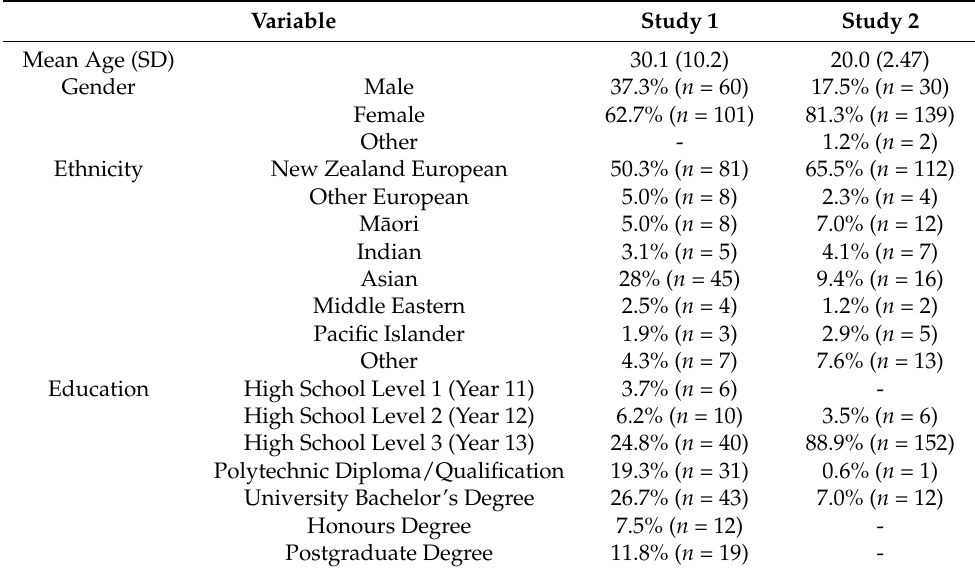
Table 1. Sample demographic information for Study 1 and Study